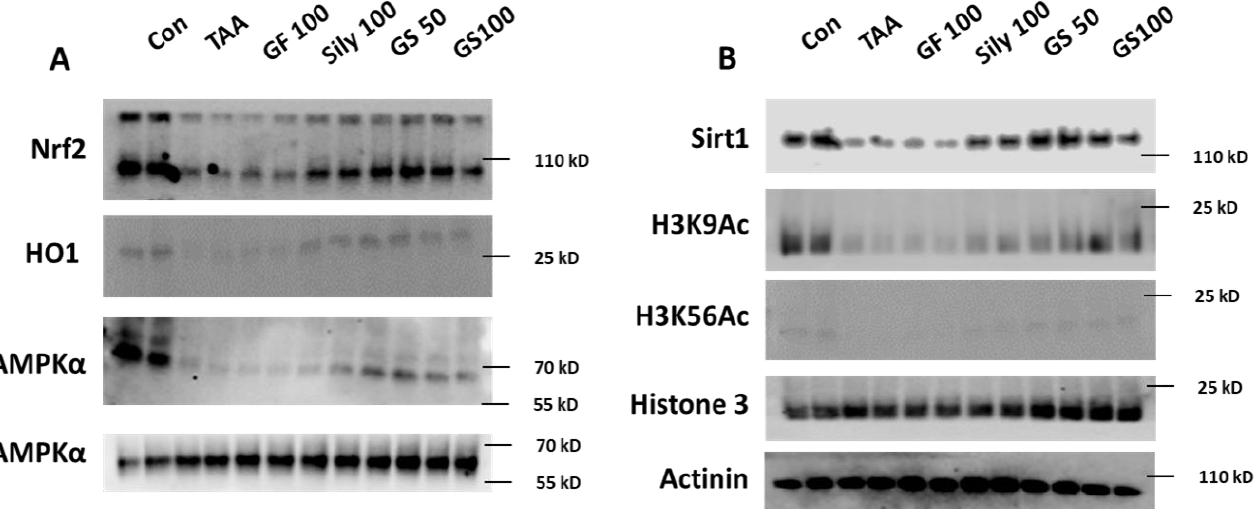
Figure 6. Pharmacological actions of GS through Nrf2/HO-1 signaling pathway via regulations of hepatic Sirt1 activation. Representative images of Western blot analysis ( A ) Nrf2/HO-1 signaling pathways, ( B ) Sirt1 activities in hepatic protein levels ( n = 4 for Western blot analysis).